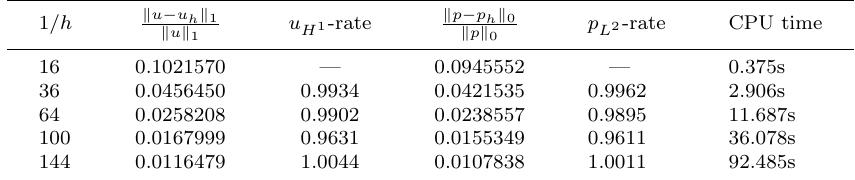
Table 4. Relative error and convergence rate of the one-grid method for the velocity and flux with τ 2 = h and ν = 0 . 1. 1 /h